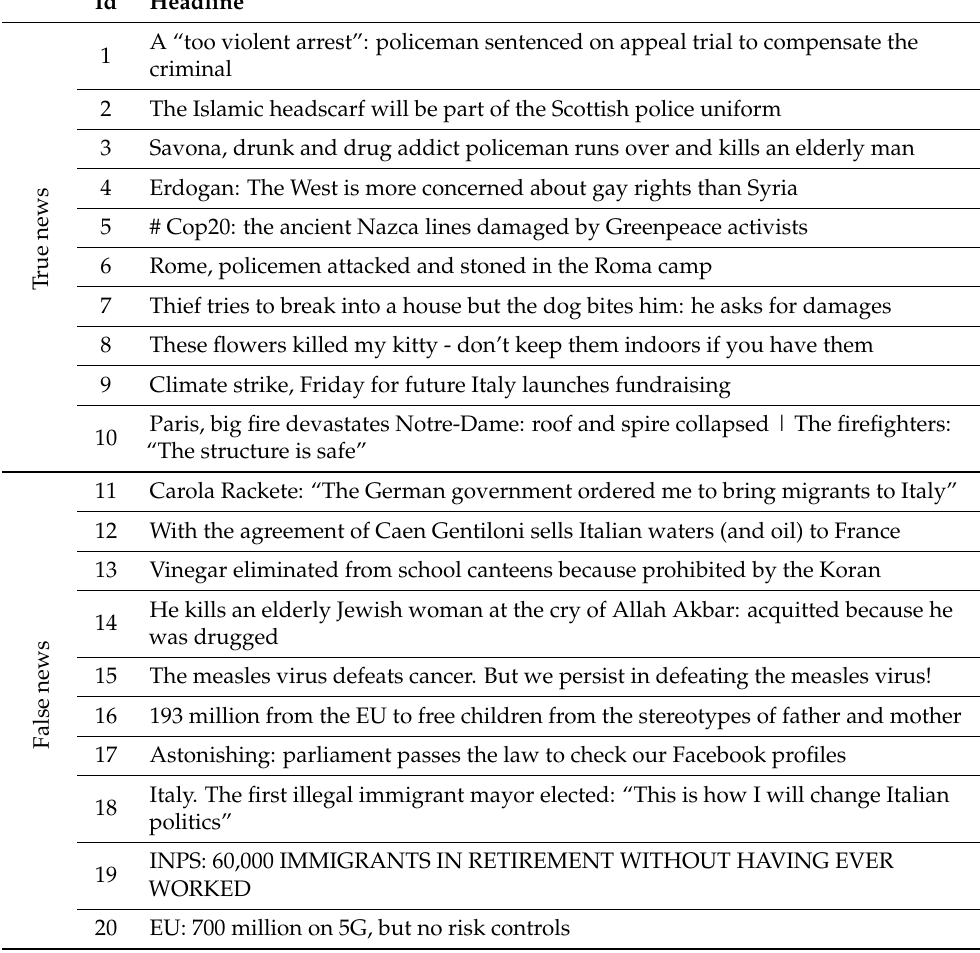
Table A1. News headlines’ list. In our experiment, we adopted 20 articles corresponding to 10 true and to 10 false news. They were actually published in Italian online outlets, mainstream or not. In all the rooms, we integrally reported headlines and short excerpts, but the full articles were available only in Room 2. In this table, we show the (translated)